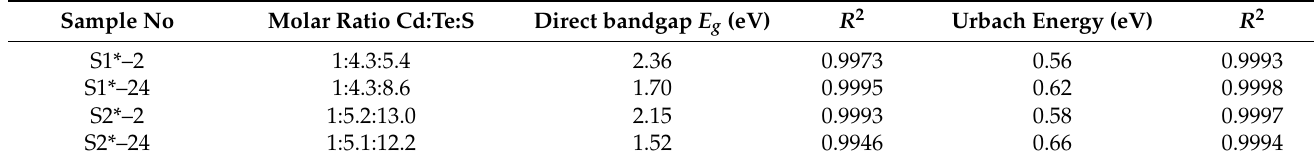
Figure 4. Tauc plots ( top ) and Urbach plots ( bottom ) of cadmium chalcogenide layers on PA 6. Table 5. Optical properties of cadmium chalcogenide